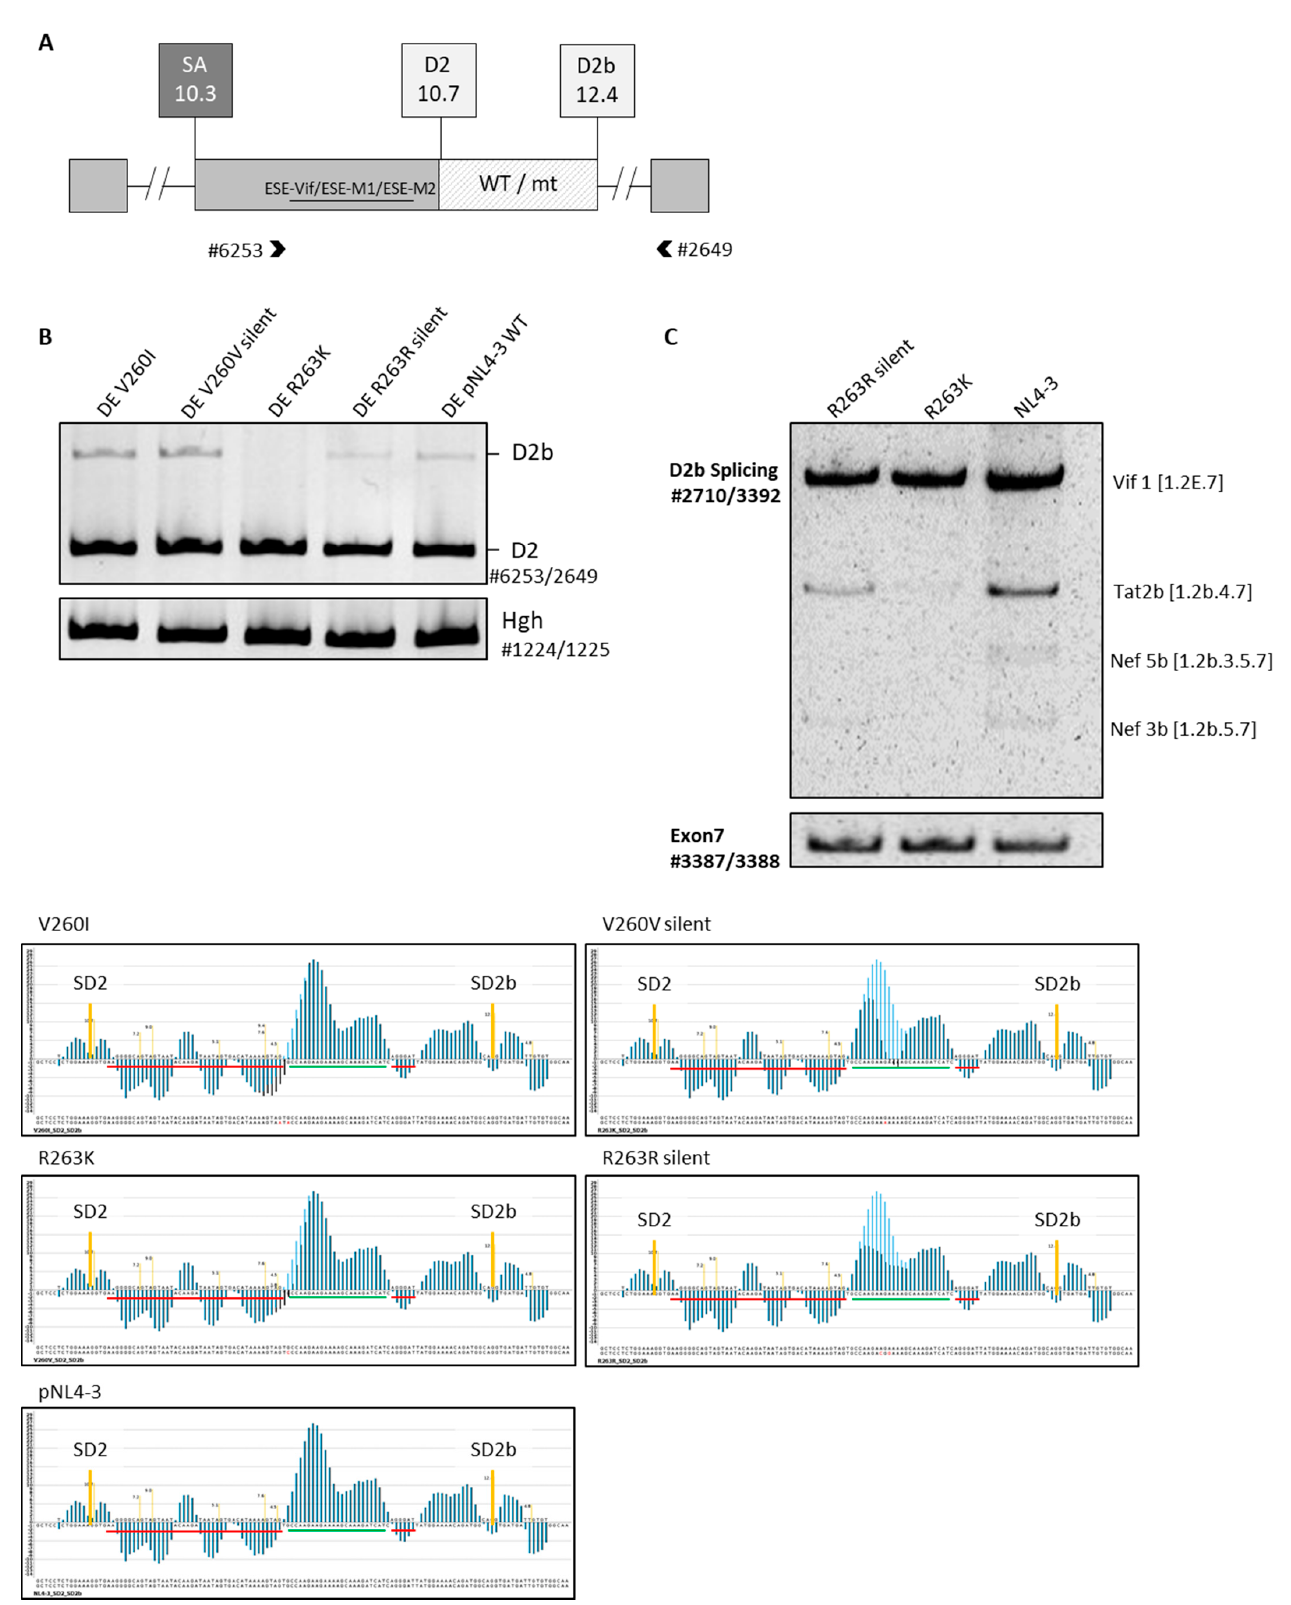
Figure 3. Silent variant of R263K with a comparable effect on SREs: ( A ) schematic overview of the three-exon minigene-splicing reporter containing the HIV-1 native splice donors SD2 and SD2b. Parental or mutated sequences are inserted between the two splice donors. The lower panel shows